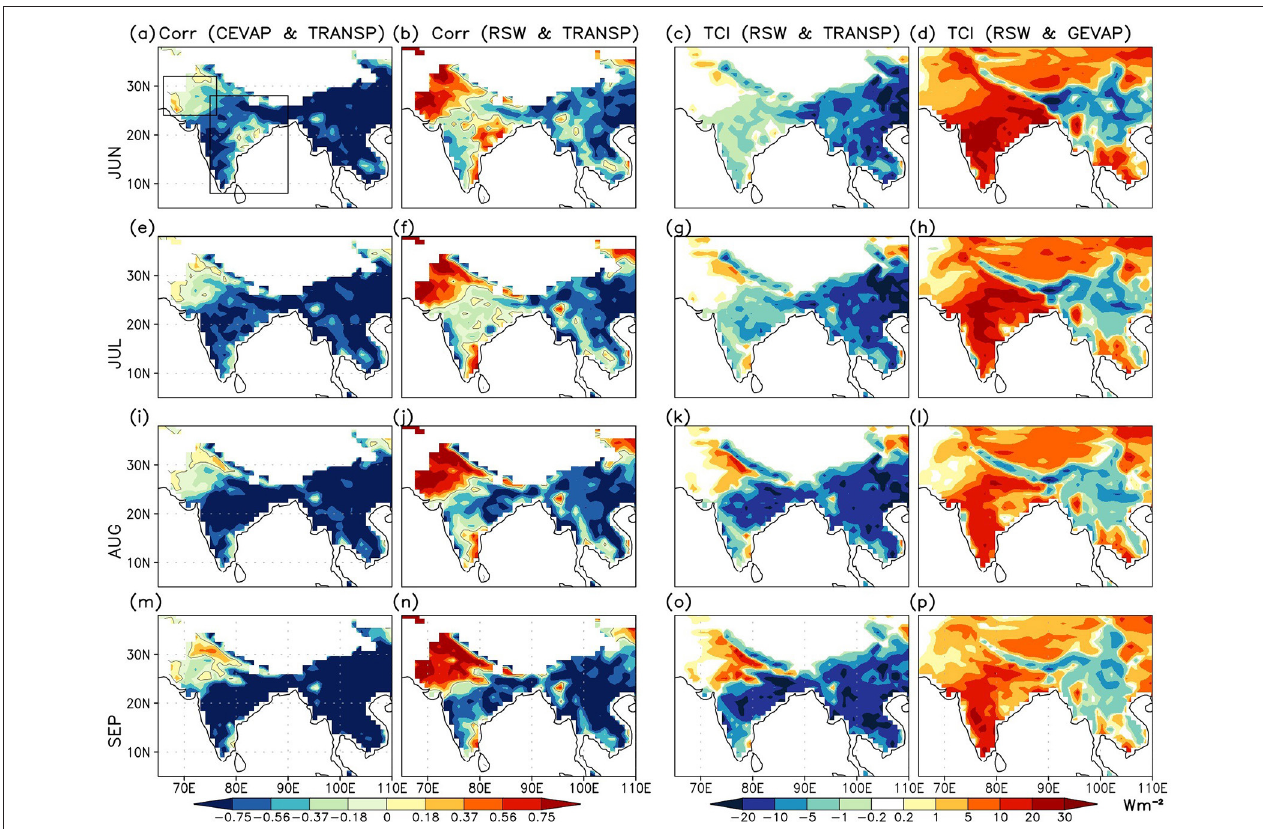
FIGURE 13 | Corelation of transpiration (TRANSP) with (a) canopy evaporation (CEVAP,) and (b) root zone soil wetness (RSW) in June based on CFSv2 MAYIC hindcasts. Terrestrial coupling index (TCI) between RSW and (c) TRANSP and (d) ground evaporation (GEVAP) in June. Units for TCI are Wm − 2 . (e–p) depict similar relationships for the months July, August, and September,